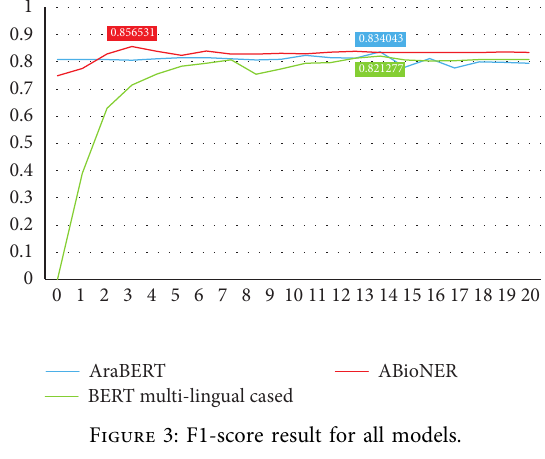
Figure 3: F1-score result for all